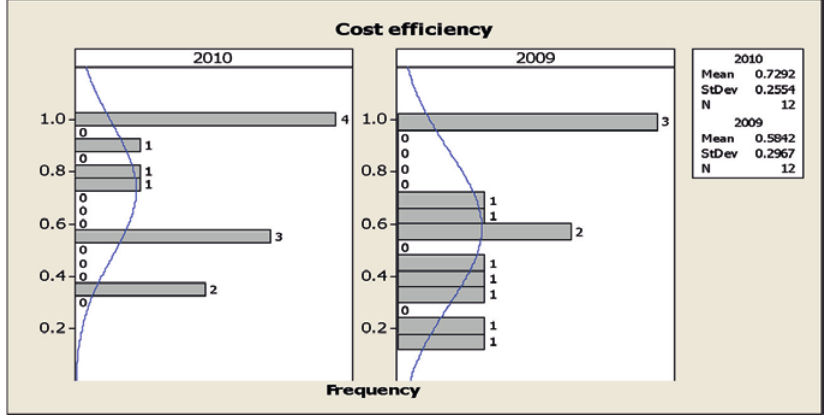
Figure 2. Cost efficiency trend among real estate and construction companies in Iran